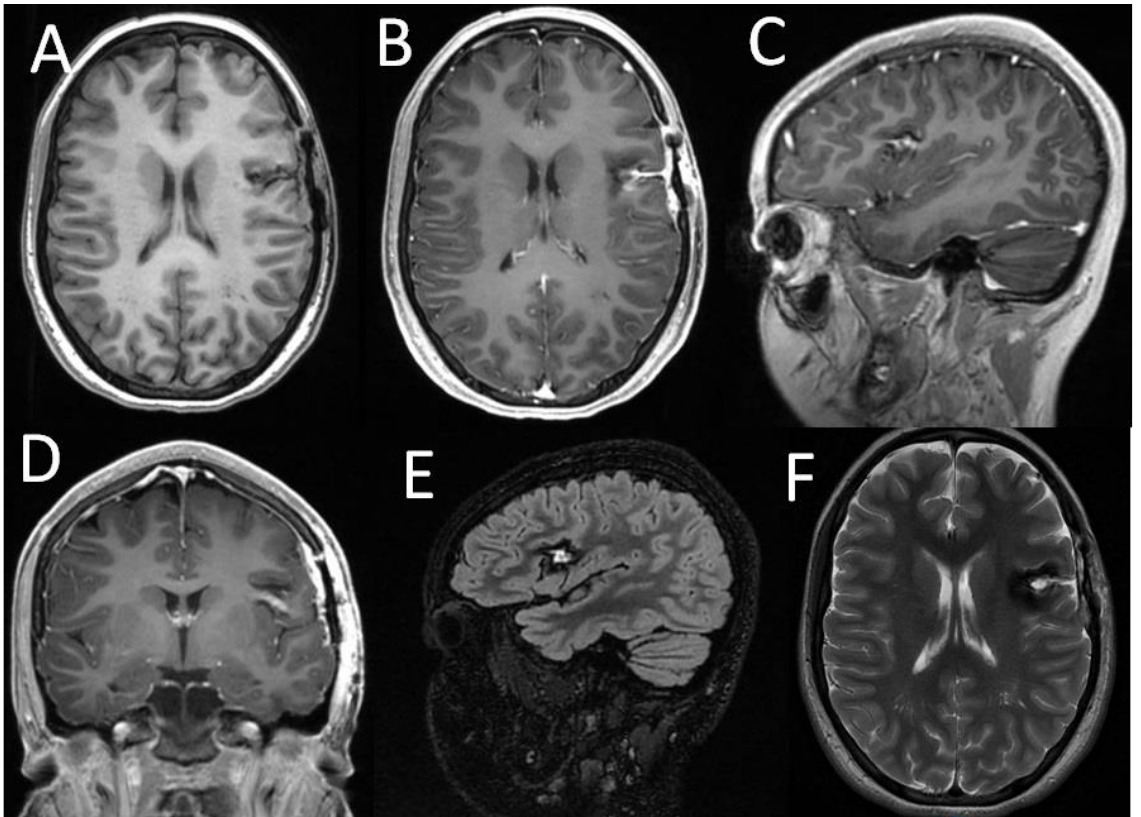
Figure 3 – Post operative MRI showing lesion aspect in T1-weighted sequences, axial non contrasted (A), axial contrasted (B), sagittal contrasted (C) and coronal contrasted (D). Flair Sagittal (E). T2 axial (F).